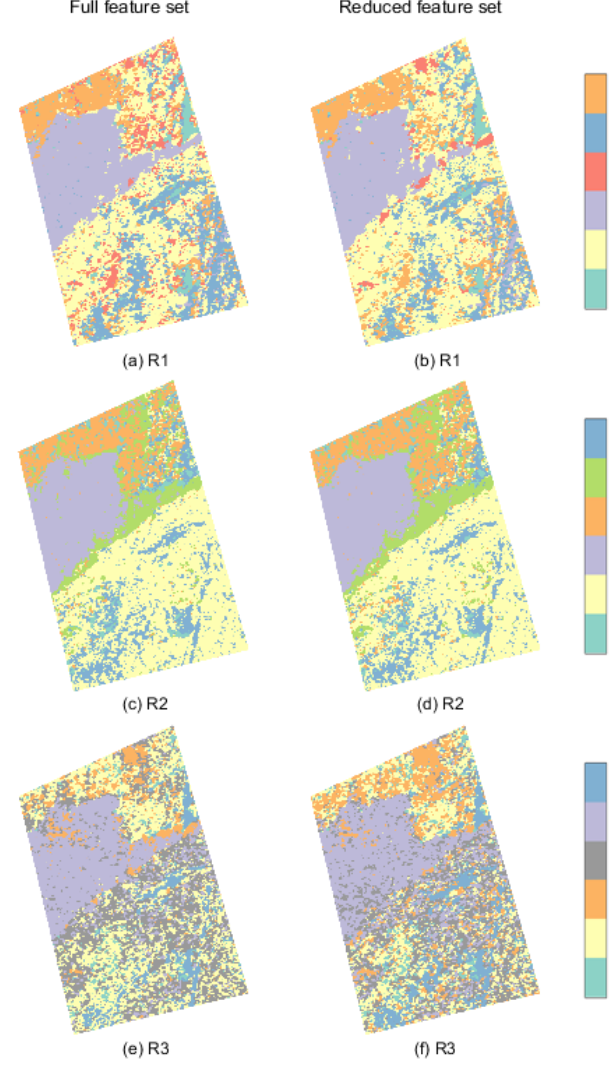
Figure 8. Segmentations of the three RADARSAT-2 scenes (R1, R2 and R3) into six segments. To the left: segmentation with full feature set. To the right: segmentation with reduced feature set consisting of relative kurtosis, geometric brightness, cross-polarisation ratio and co-polarisation